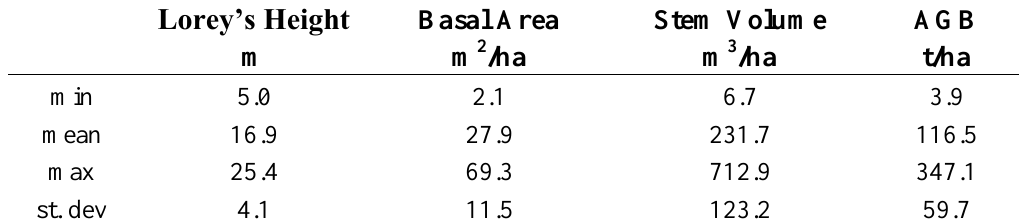
Table 1. Summary of the field